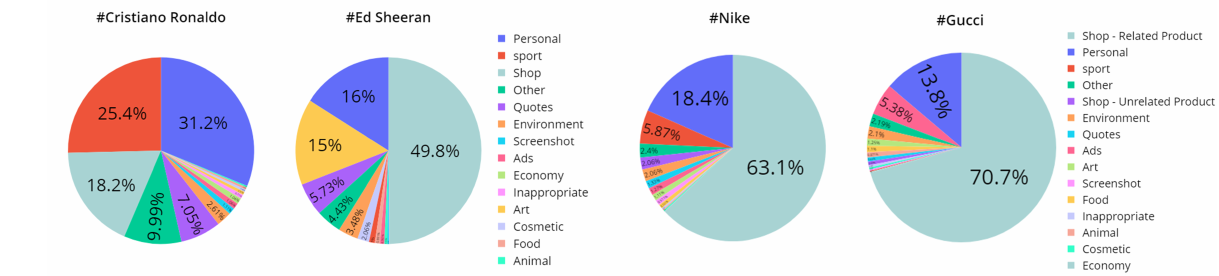
Figure 6. Distribution of the main mismatch topics over posts in the dataset.